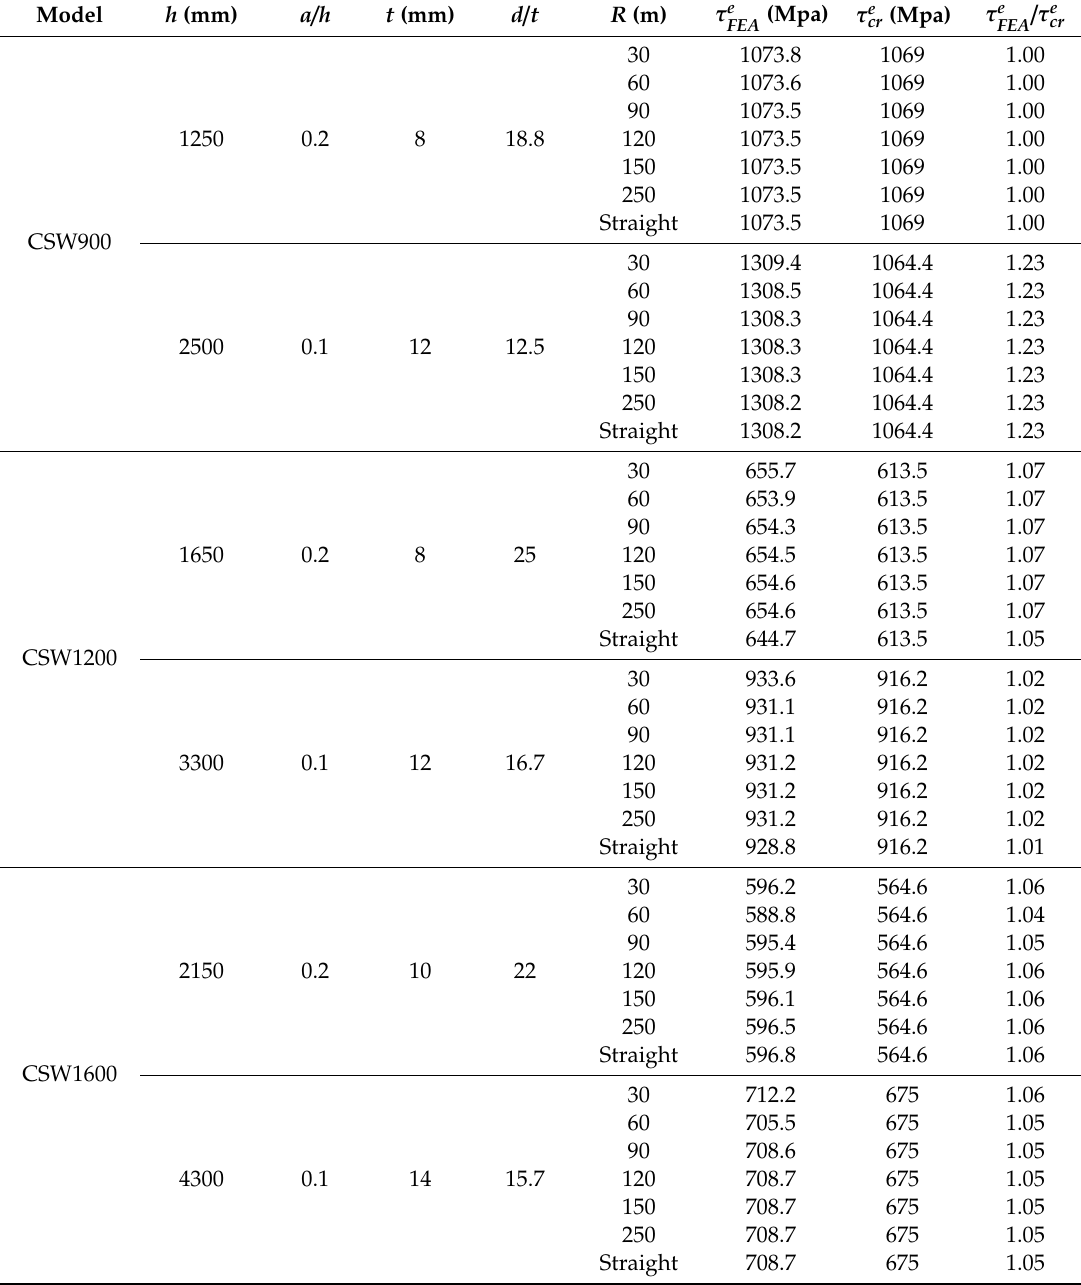
Table 9. Elastic shear buckling stress of CSWs for di ff erent radii of curvature.